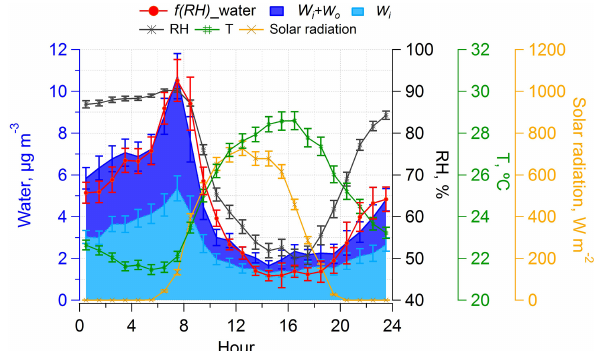
Figure 3. CTR (SOAS) diurnal profiles of predicted and measured water, measured RH, T , and solar radiation. Median hourly aver- ages are shown, and standard errors are plotted as error